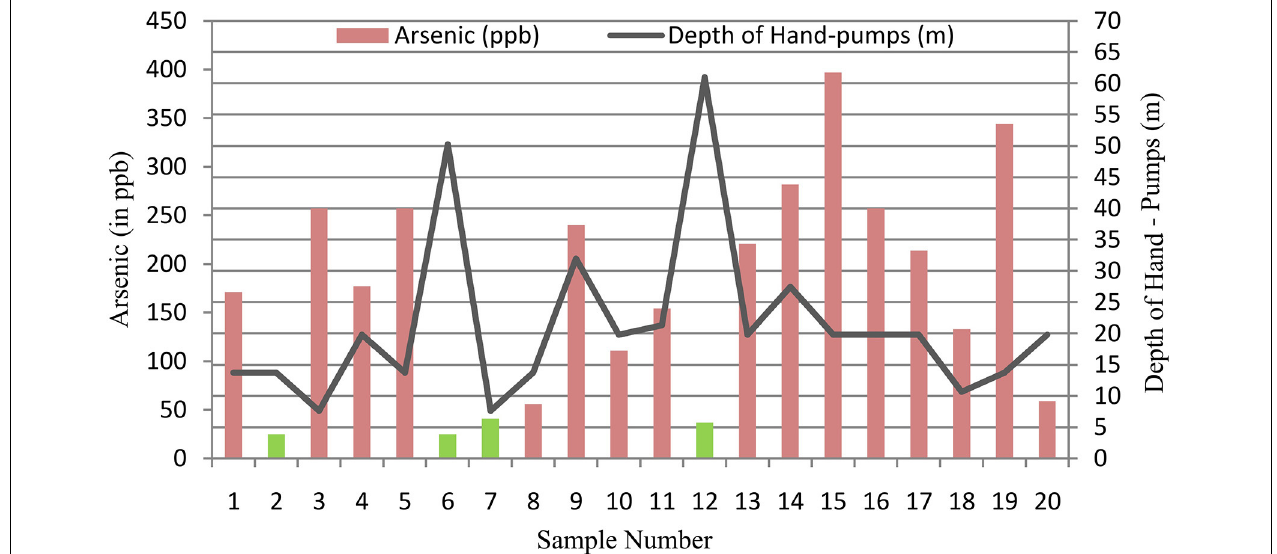
FIGURE 2 | Relation between arsenic values (ppb) and depth of hand-pumps (m) for drinking water sample testing and analysis. 57% of the private hand-pumps in the 15–35m zone have arsenic greater than 200